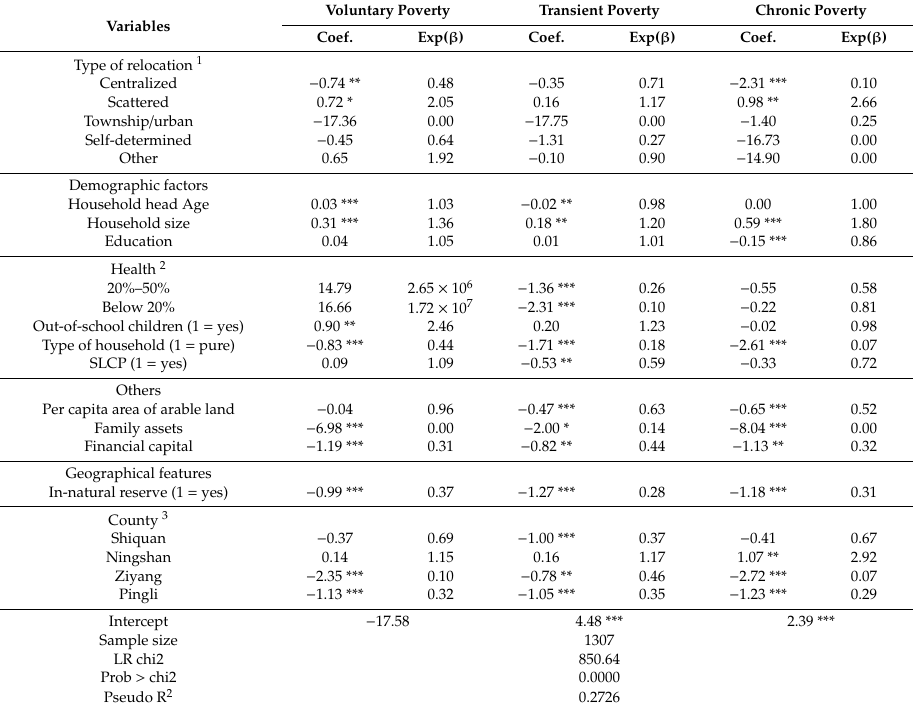
Table 5. Multinomial logistic model regression results of type of relocation.